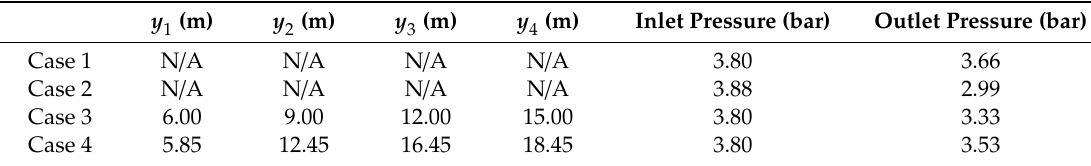
Table 8. Comparison of pressure loss along air booster positions.